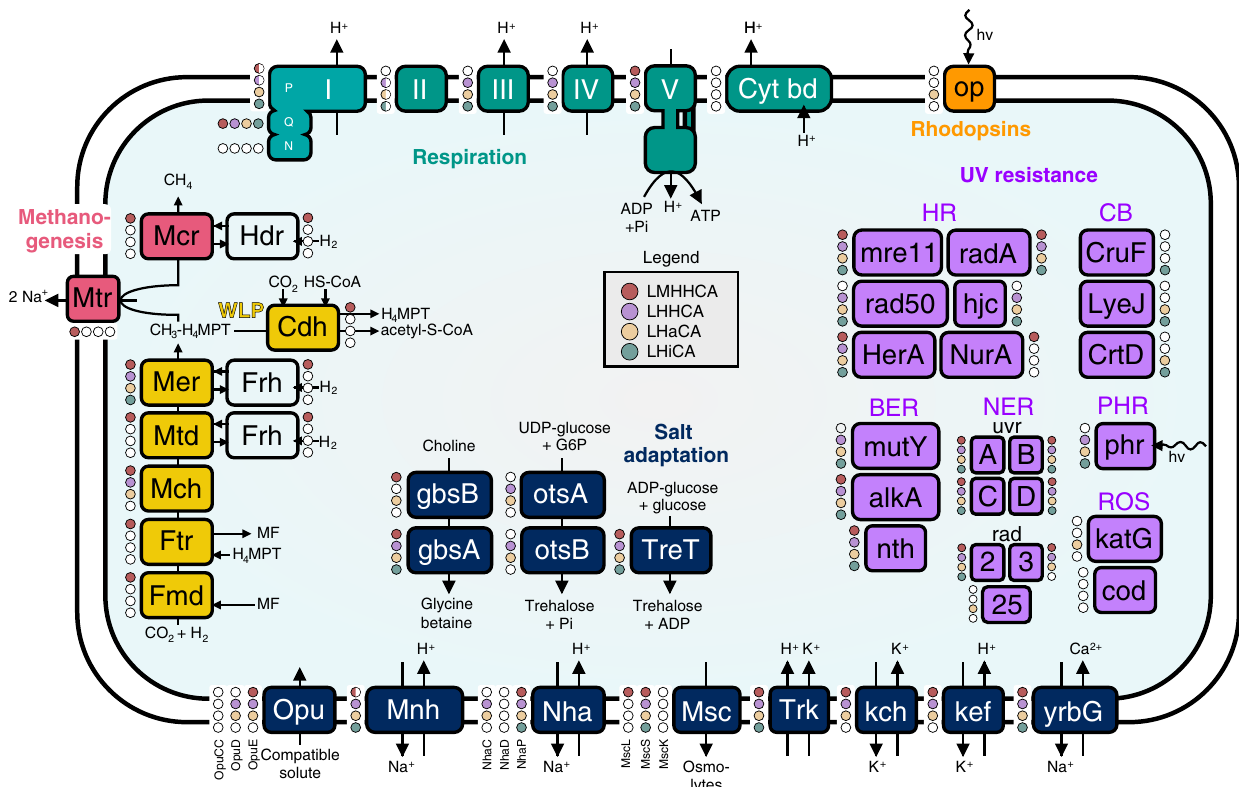
Fig. 4 Ancestral gene content reconstruction. Inferred presence and absence of gene families functionally related to methanogenesis, aerobic respiration, salt adaptation, UV resistance, and rhodopsins in the LMHHCA, LHHCA, LHaCA, and LHiCA ancestors. A gene (or protein complex) was considered present if it (or at least half of the subunits) was inferred to be present by ALE with copy number ≥ 0.3. Note that genes homologous to components of the NADH dehydrogenase in LMHHCA may alternatively encode components of alternative [Ni – Fe] hydrogenases (Supplementary Data 4). Gene families encoding independently acting proteins but with similar names (e.g., NhaC and NhaD) are enumerated separately. See Supplementary Data 4 for